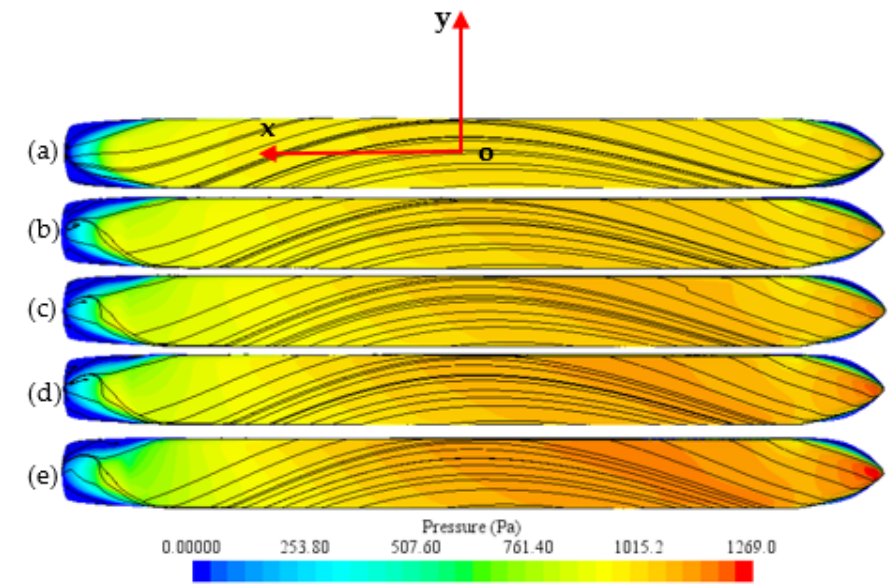
Figure 20. Pressure contours with streamlines of current velocity. ( a – e ): current velocity = 0 m/s, 0.1 m/s, 0.15 m/s, 0.2 m/s, 0.25